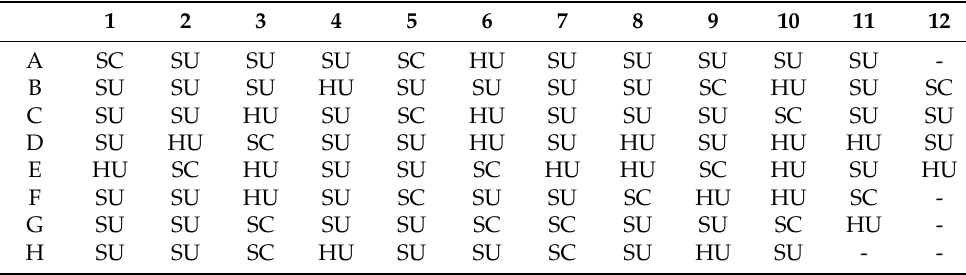
Table 1. Yeast species identified in each well of the 96-well MSPC yeast collection plate. Saccharomyces cerevisiae (SC); Saccharomyces uvarum (SU); Hanseniaspora uvarum (HU); Empty well